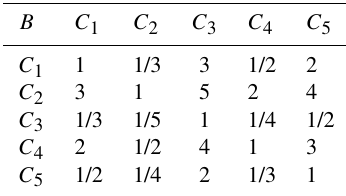
Table 8. Standard table of multiple comparison of B 1 – C